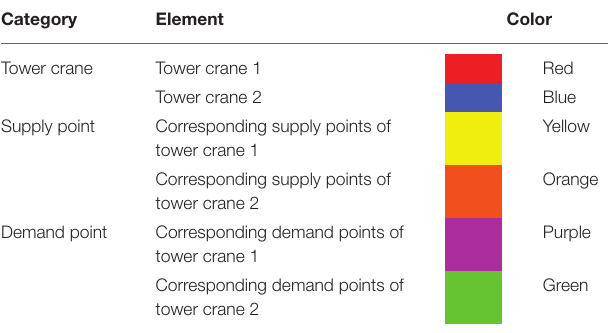
TABLE 1 | Example for the normal-level